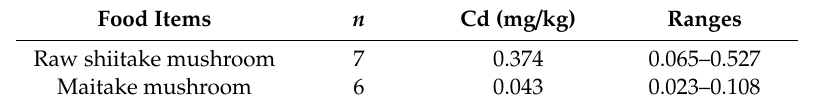
Table 5. Cadmium (Cd) concentrations in mushrooms. Data are presented as arithmetic means.